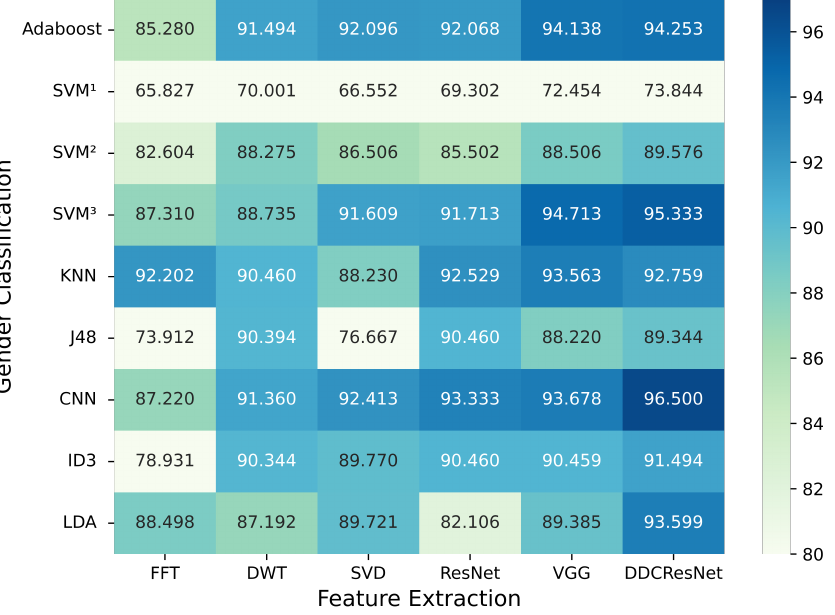
Figure 5. This is a heat map of different networks. The x axis presents the network of feature extraction model and the y axis presents the network of a gender classification model. Value in each cell represents the average accuracy (%) . The most accurate model pair is the CNN and the DDCResNet